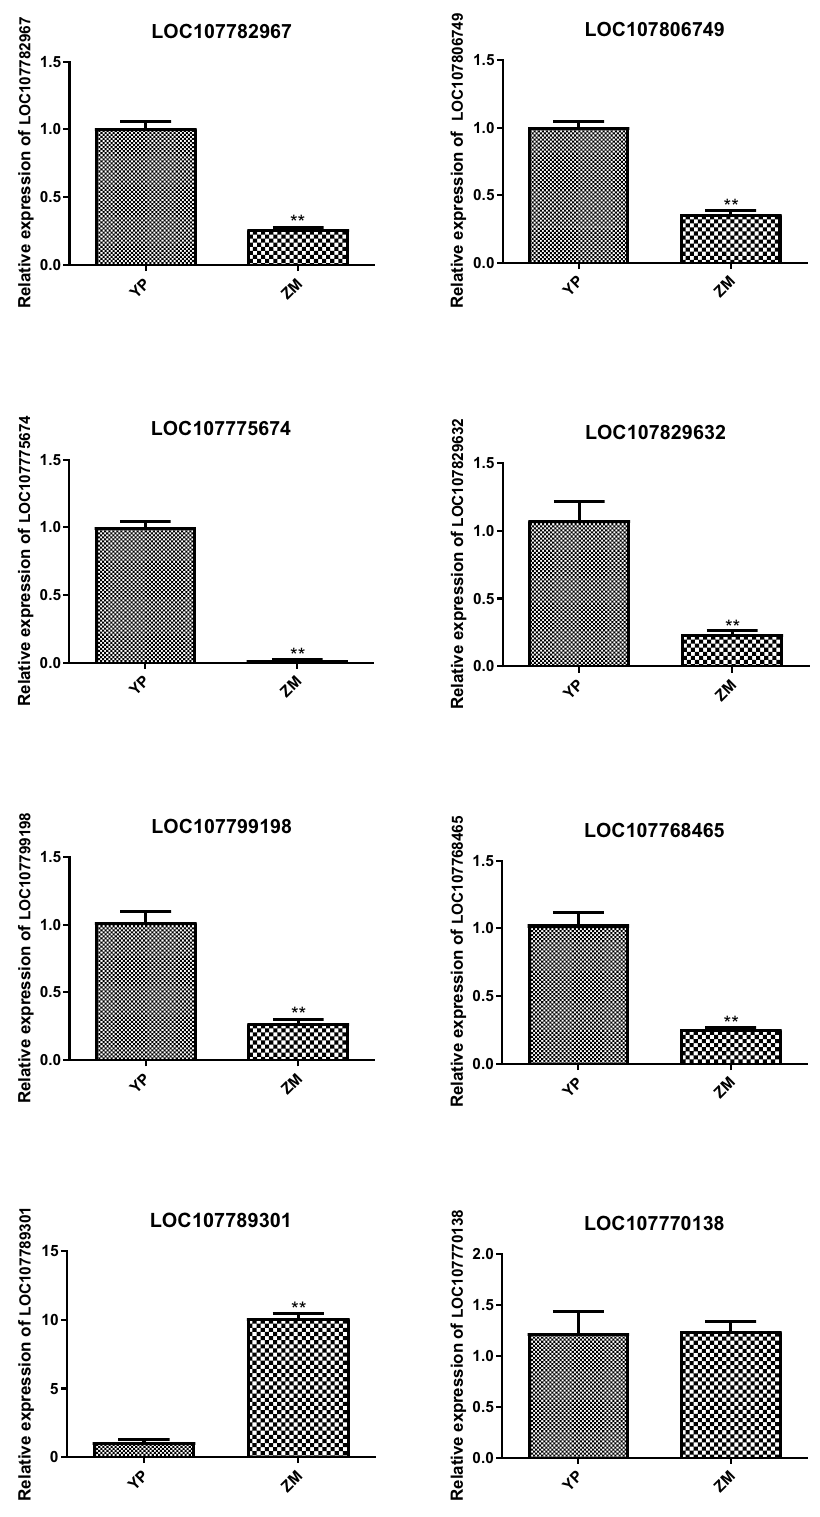
Figure 5. Expression levels of genes related to nitrate transport by qRT-PCR. The x-axis indicates the two samples. YP: lamina of flue-cured tobacco; ZM: midrib of flue-cured tobacco. The left y-axis indicated relative expression level of qRT-PCR. Error bars represent standard error of